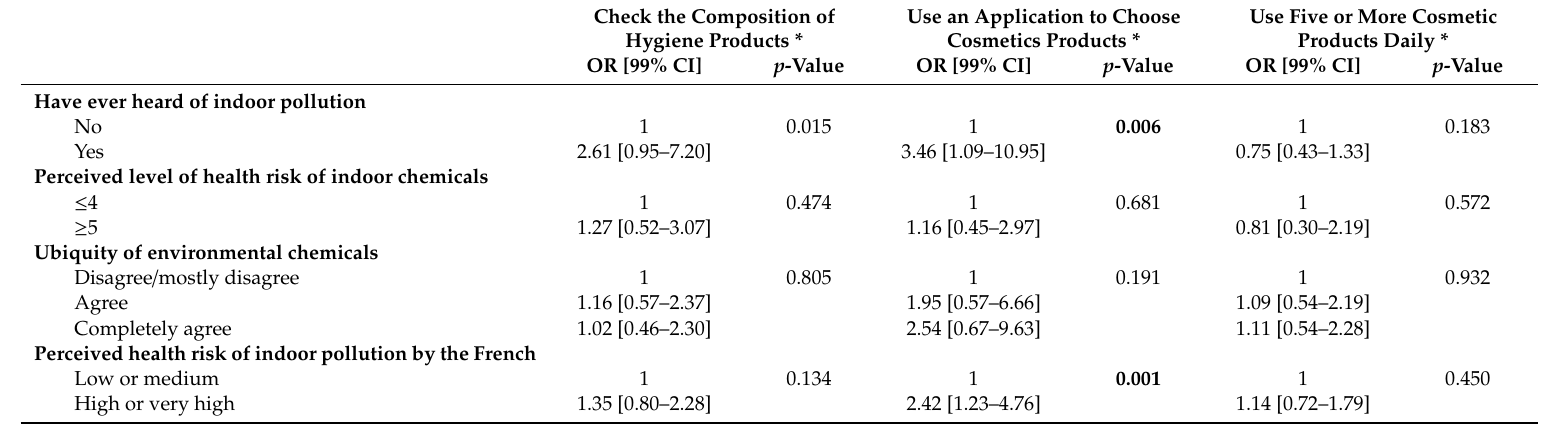
Table 4. Practices concerning hygiene and cosmetics according to the level of awareness / perceptions.